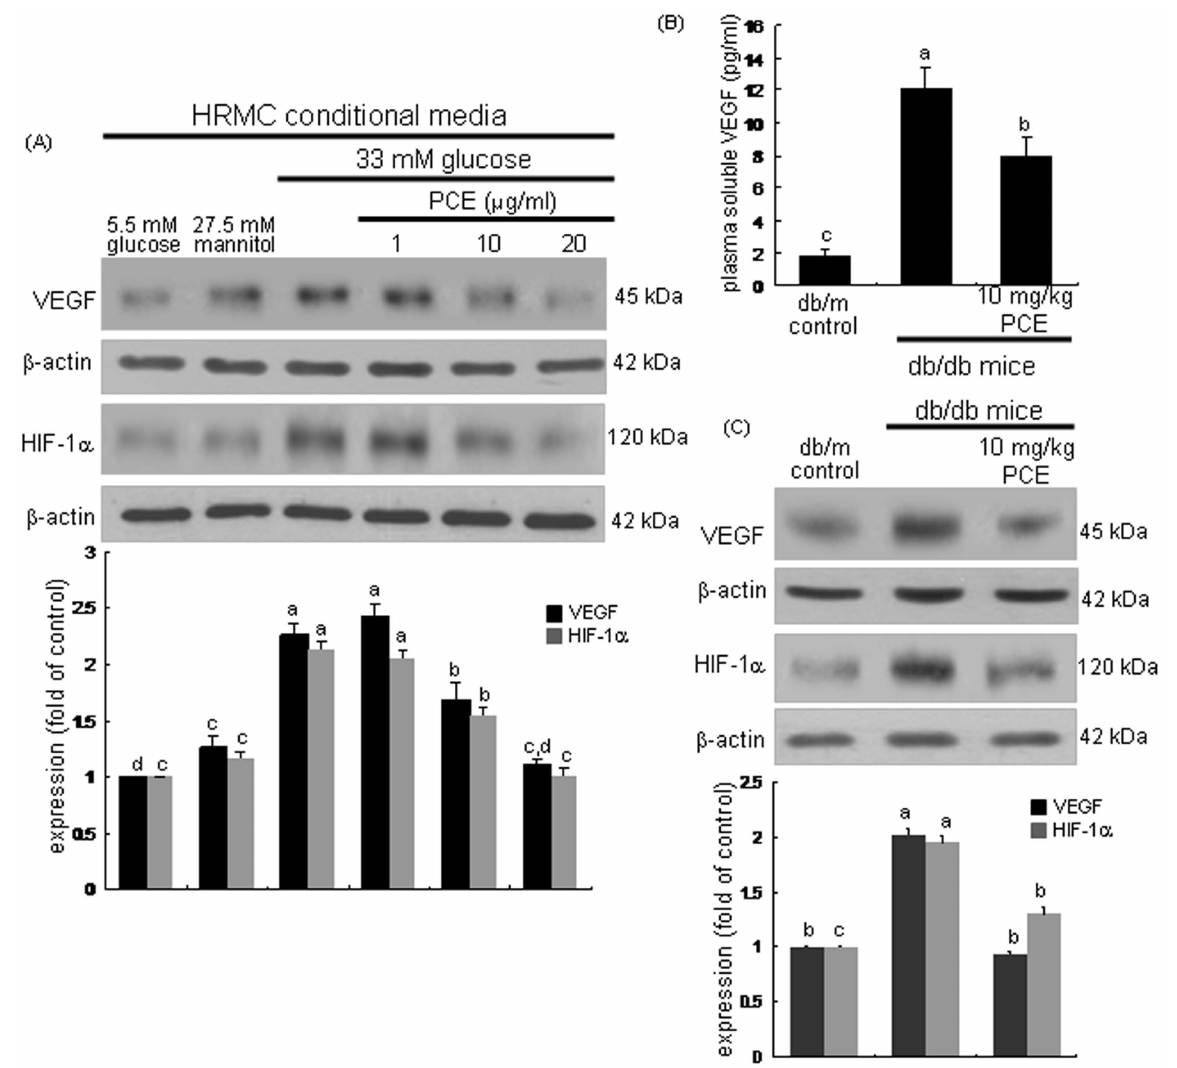
Figure 1. Inhibition of diabetic up-regulation of VEGF and HIF-1 a by PCE. HRMC were incubated in 5.5 mM glucose and plus 27.5 mM mannitol for osmotic control or 33 mM glucose. HUVEC were incubated in HRMC conditioned media [with (w/) 27.5 mM mannitol and w/33 mM glucose] for 6 h in the absence and presence of 1–20 m g/ml PCE (A). The db/db mice were orally supplemented with 10 mg/kg PCE daily for 8 weeks. The db/m mice were employed as diabetic controls (B and C). Cell lysates and tissue extracts were subjected to Western blot analysis with a primary antibody of VEGF and HIF-1 a (A and D). b -Actin protein was used as an internal control. The bar graphs (mean 6 SEM, n=3) in the bottom panels represent quantitative results obtained from a densitometer. Plasma level of VEGF in mice was measured with an ELISA kits (B). Means not sharing a common letter differ, P , 0.05.